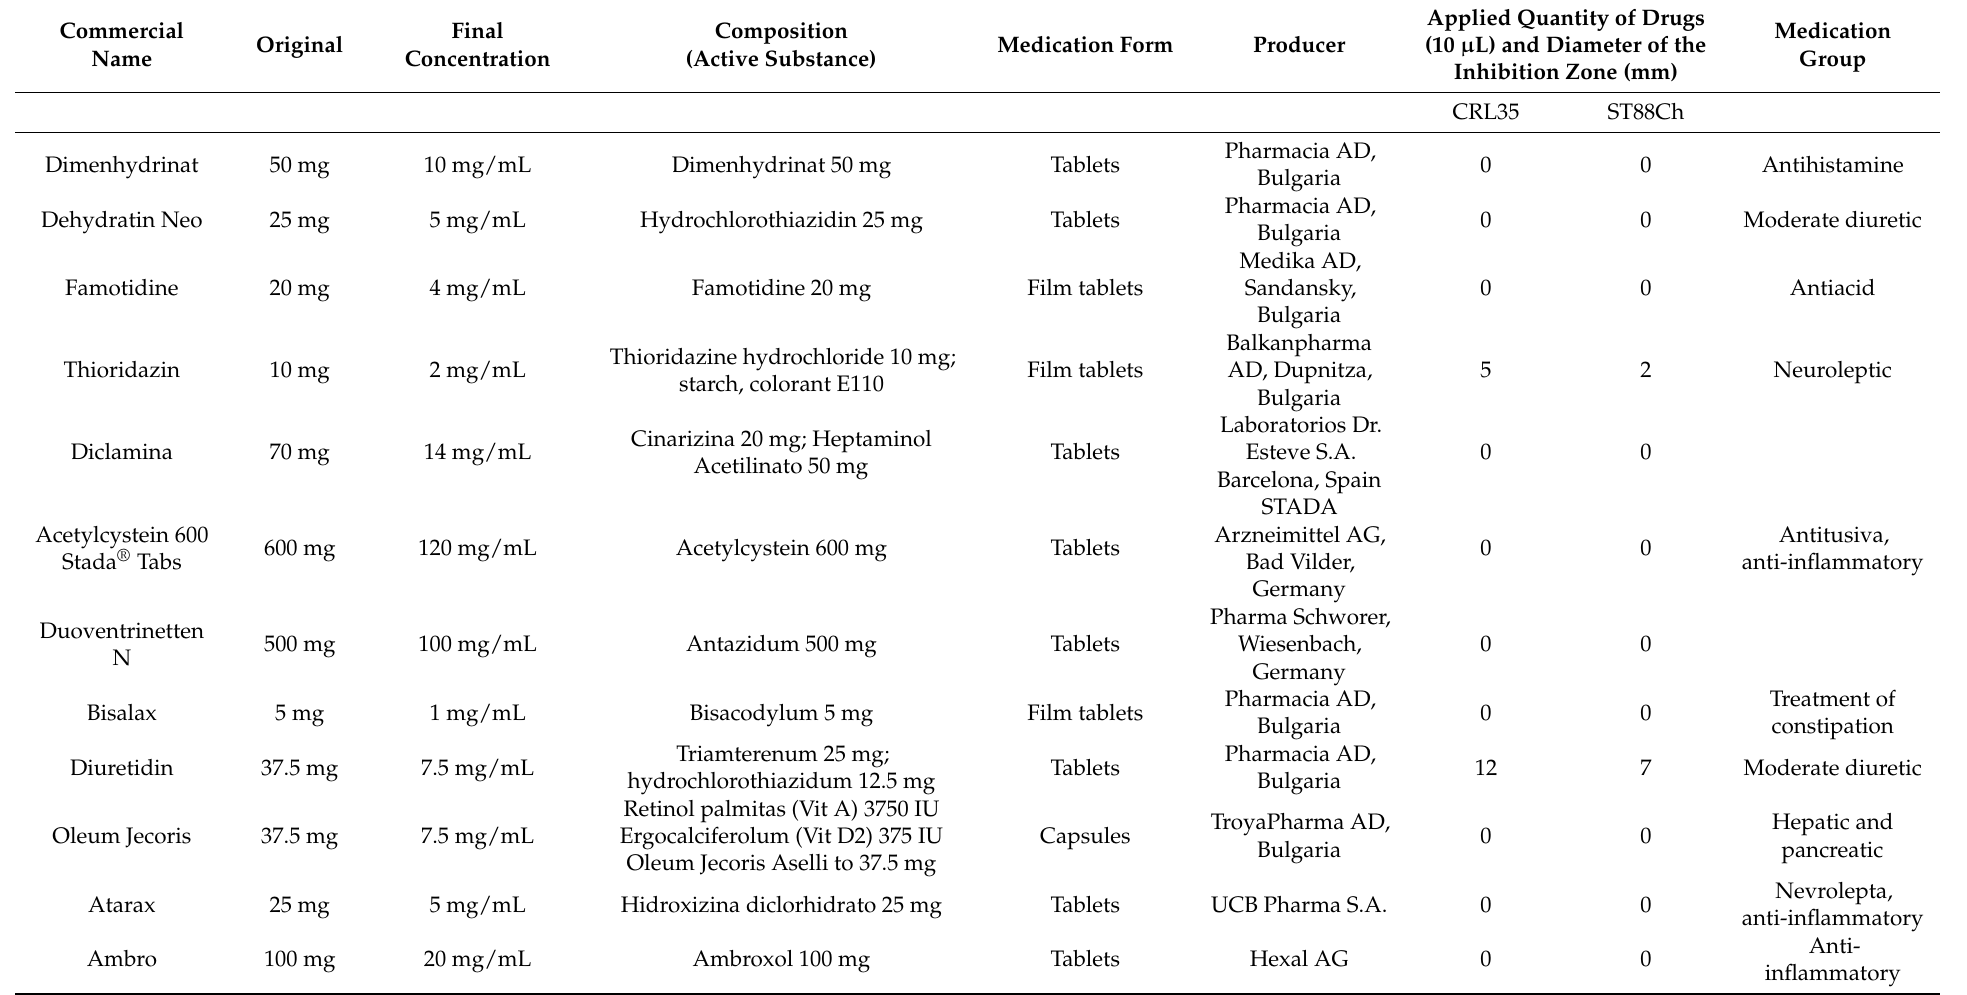
Table 2. Effect of commercial drugs on bacterial growth of Enterococcus mundtii CRL35 and Enterococcus faecium